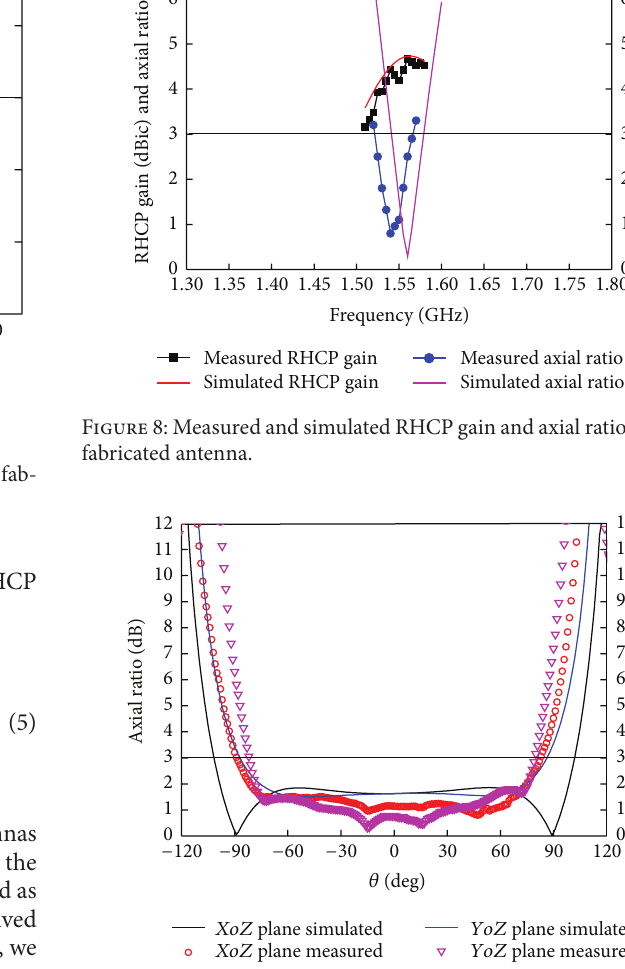
Figure 9: Measured and simulated axial ratio spatial distribution at 1.55